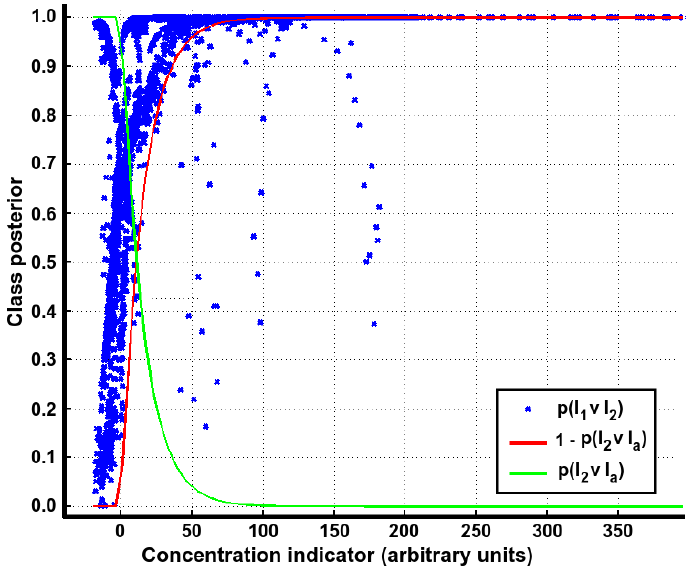
∨ l ) and the red 1 2 ∨ l ) 2 a